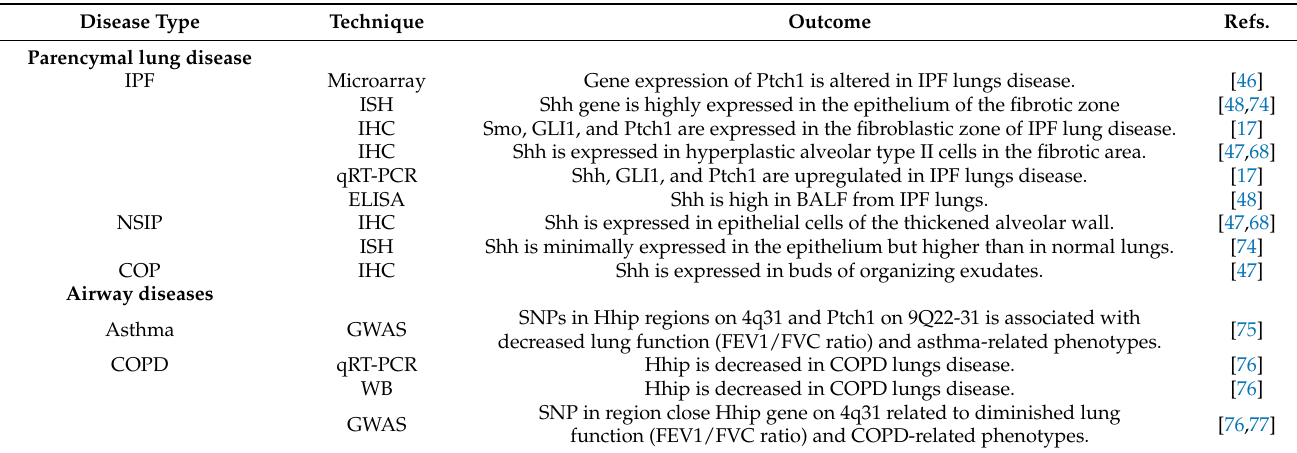
Table 2. Hedgehog signaling in human lung